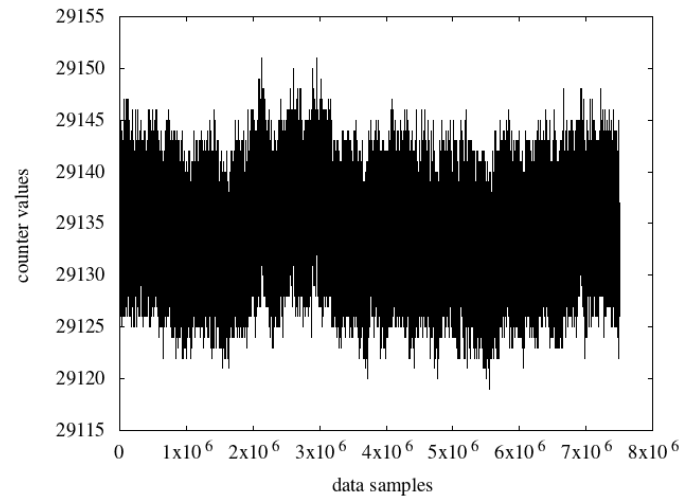
Figure 15: Counter values acquired when both oscillators are implemented in the FPGA